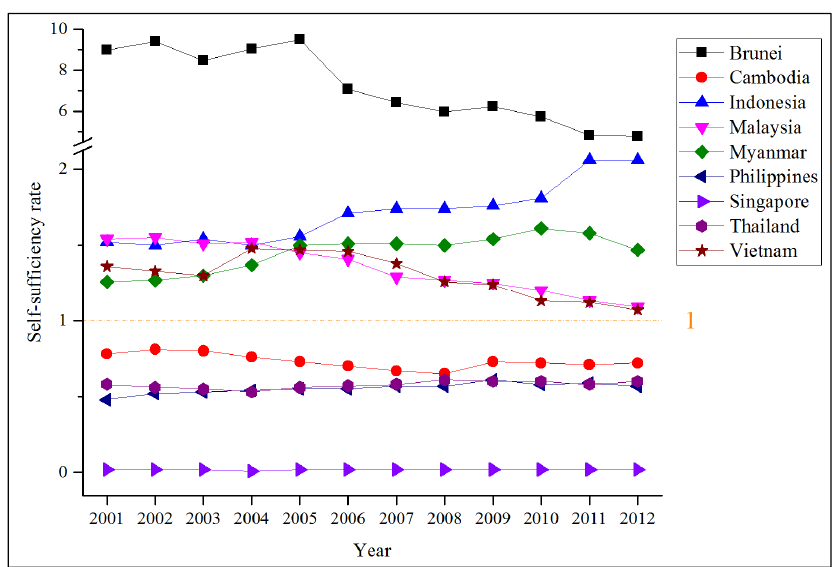
Figure 33. Overall self-sufficiency rate.